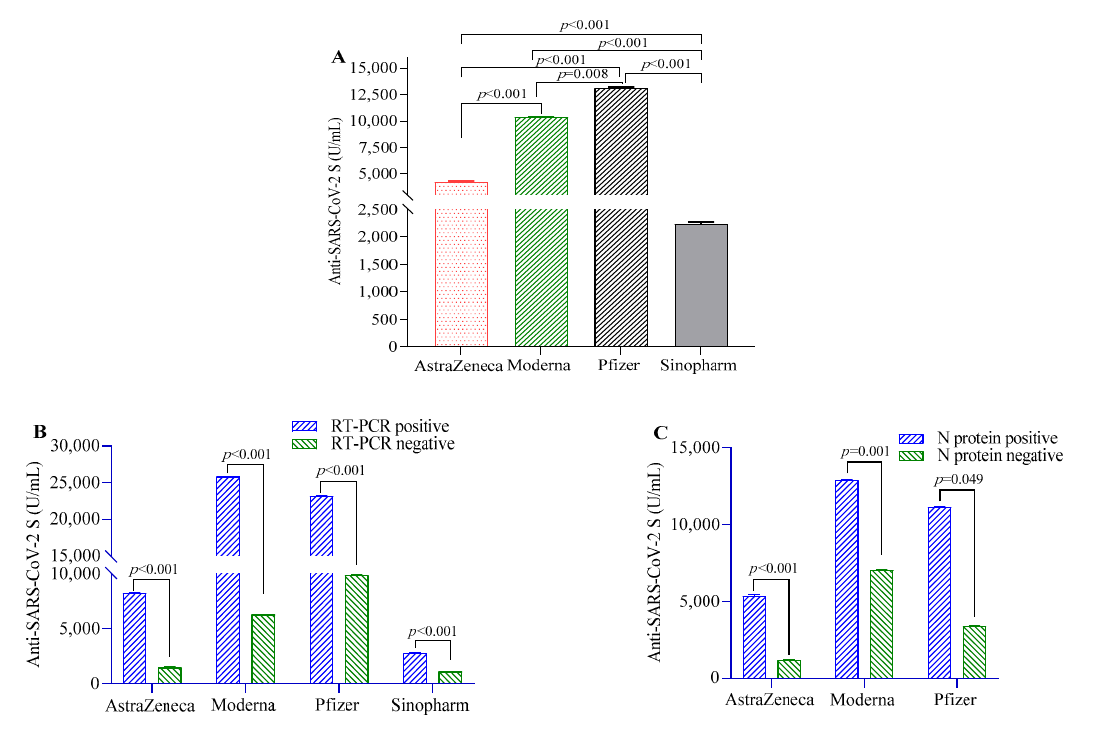
Figure 1. SARS-CoV-2 S-protein-specific antibody levels in study participants after two doses of vaccination. ( A ) Comparison of antibody levels between different SARS-CoV-2 vaccines; ( B ) differences in antibody titer between RT-PCR positive and negative participants; ( C ) comparison of antibody levels between participants positive and negative for SARS-CoV-2 N-protein-specific antibody. A 2-way ANCOVA model was used to estimate the p -value, and the model was adjusted for age, sex, income and BMI. Table 1. Differences in antibody titers between participants with and without COVID-like symp- toms after getting 1st and 2nd doses of COVID-19 vaccines.